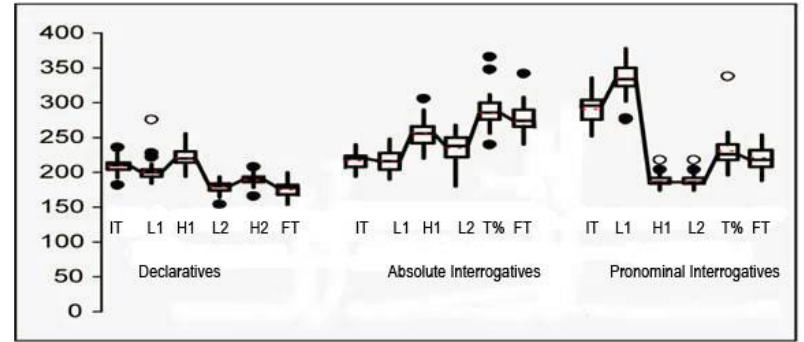
Figure 6. Box plots of comparative tonal values utterances each for declaratives, absolute interrogatives and pronominal interrogatives in Dominican Spanish for Speaker 1 speaker. Each box plot is typically based on over 30 productions of each utterance type. Similar comparative box plots for all speakers are provided in Appendix